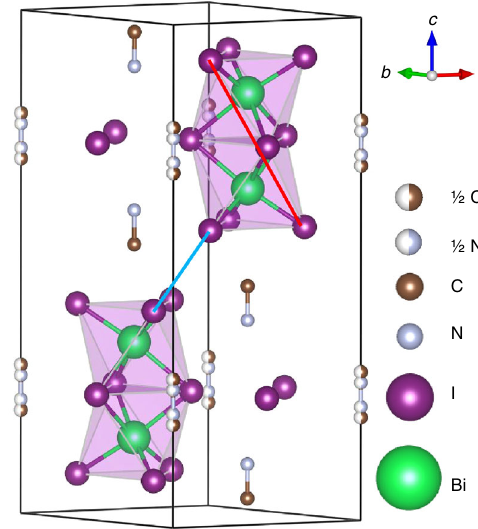
Fig. 1 Crystal structure of (CH 3 NH 3 ) 3 Bi 2 I 9 from single-crystal diffraction The hydrogen atoms are omitted. The thick light-blue line (0.43 nm) shows the shortest distance between two Bi 2 I 9 bioctohedra and the thick red line (0.85 nm) shows the distance between two furthest iodine atoms. ½ C and ½ N represent the half-occupied carbon and nitrogen sites,